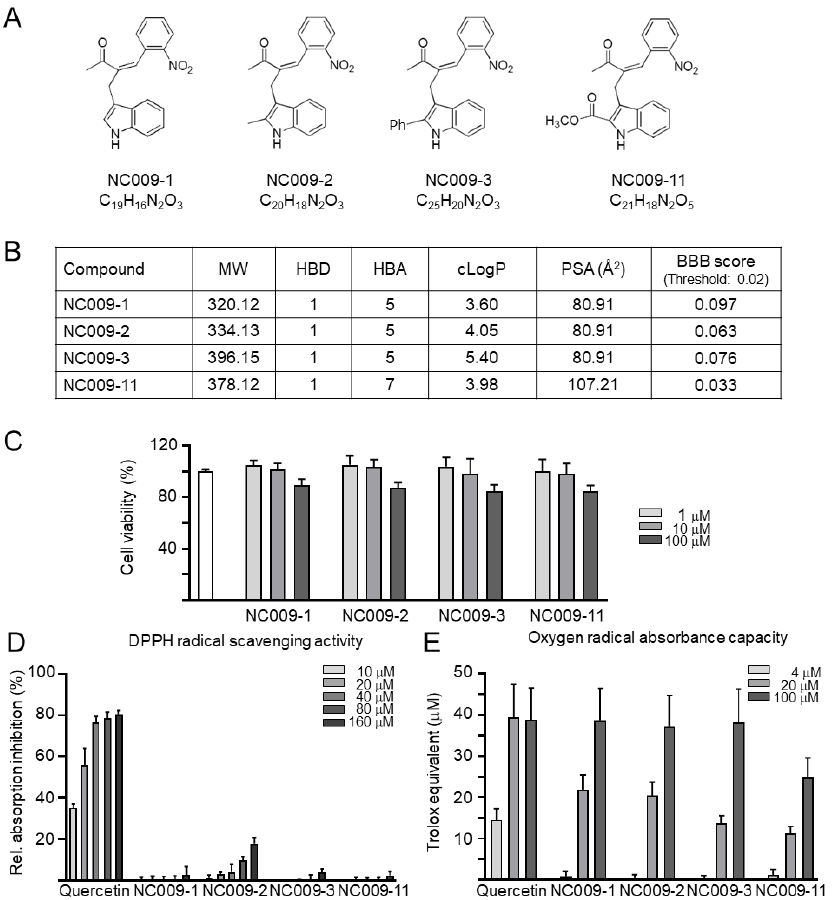
Figure 1. NC009 compounds. ( A ) Structure and formula of NC009-1, -2, -3, and -11. ( B ) Molecular weight (MW), hydrogen bond donor (HBD), hydrogen bond acceptor (HBA), calculated octanol–